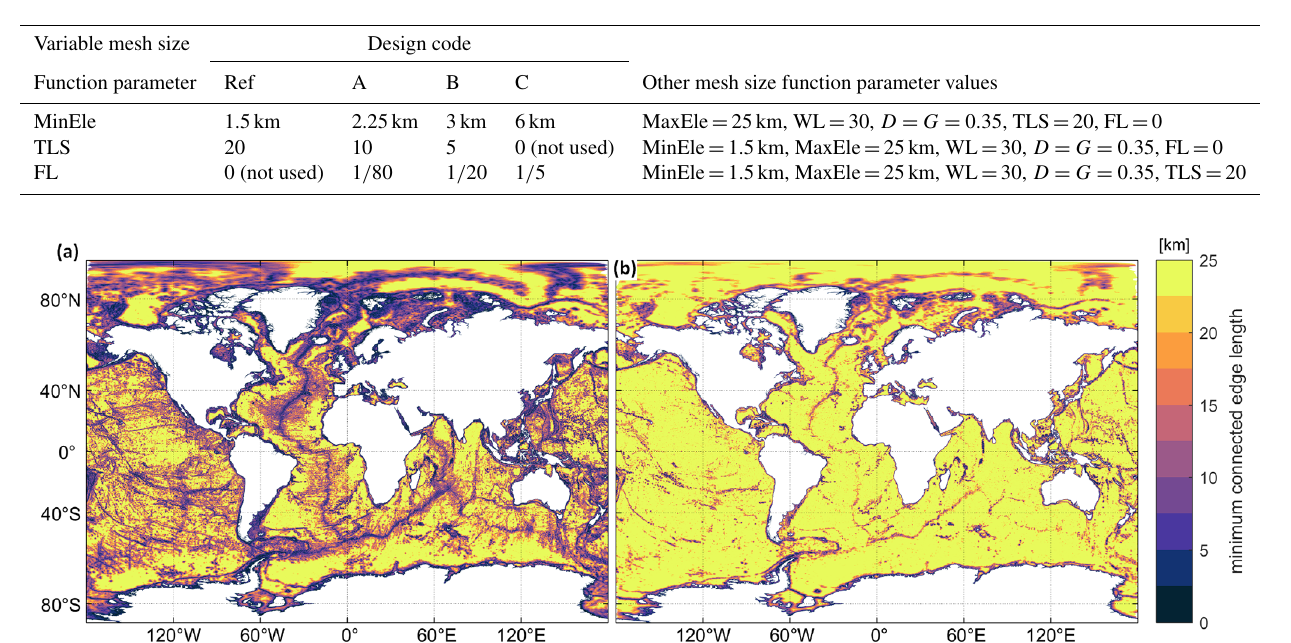
Table 2. Summary of the global mesh designs. Each row is separate and made up of three mesh designs for each variable mesh size function parameter, in addition to the Ref mesh design, which is the same for each row.